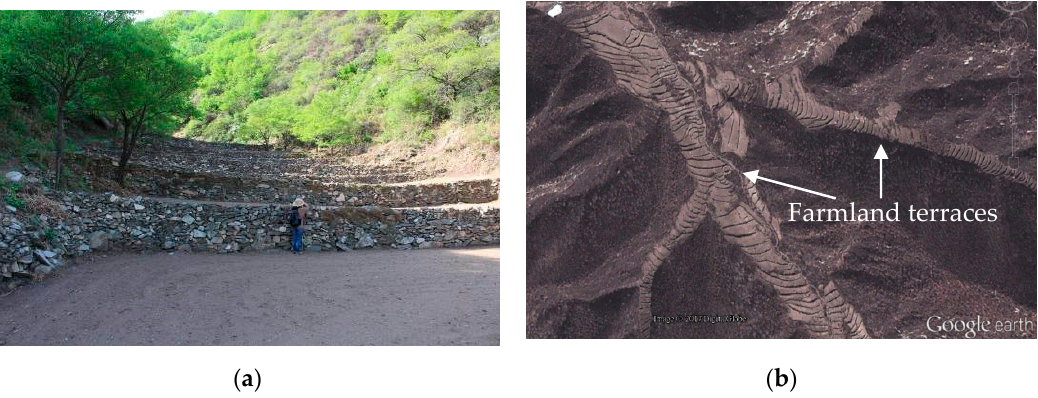
Figure 3. Farmland terraces in the study area: ( a ) field photo; ( b ) image from Google Earth.